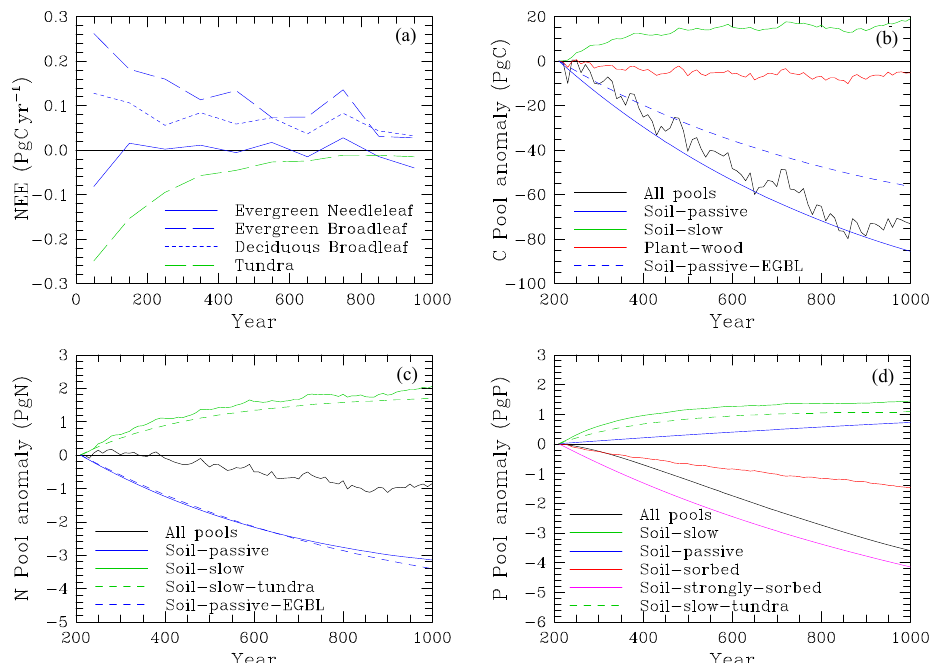
Figure 6. The 100-year mean global NEE (a) in PgCyr − 1 for selected vegetation types as listed in the key and carbon (b) , nitrogen (c) and phosphorus (d) pool sizes in PgC,PgN andPgP at the end of each 10 years relative to year 210 for the sum of all pools (black), and selected pools (as listed in the key – solid: pools summed over vegetation type; dashed: pools for listed vegetation type; EGBL is evergreen broadleaf) for the ProgLAI simulation. The horizontal black line indicates zero NEE (a) and zero pool anomaly (b–d)